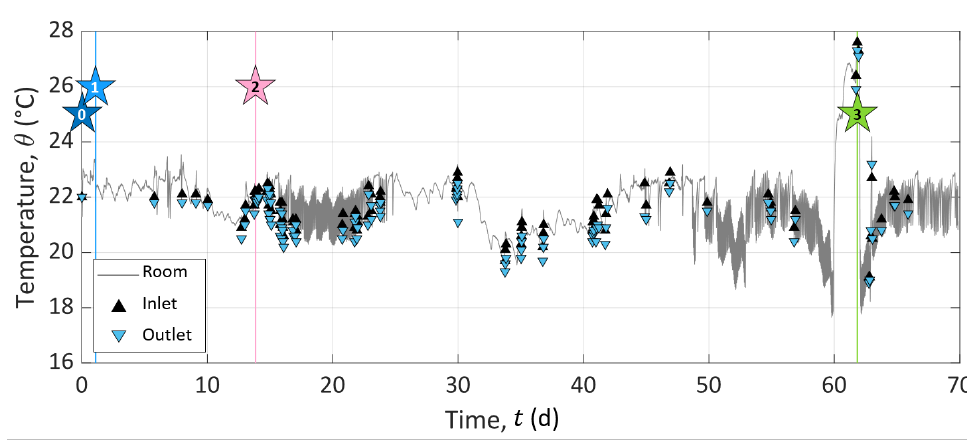
Figure A1. Temperature monitoring of the room (gray curve), the inlet pore water (black triangles), and the outlet pore water (blue